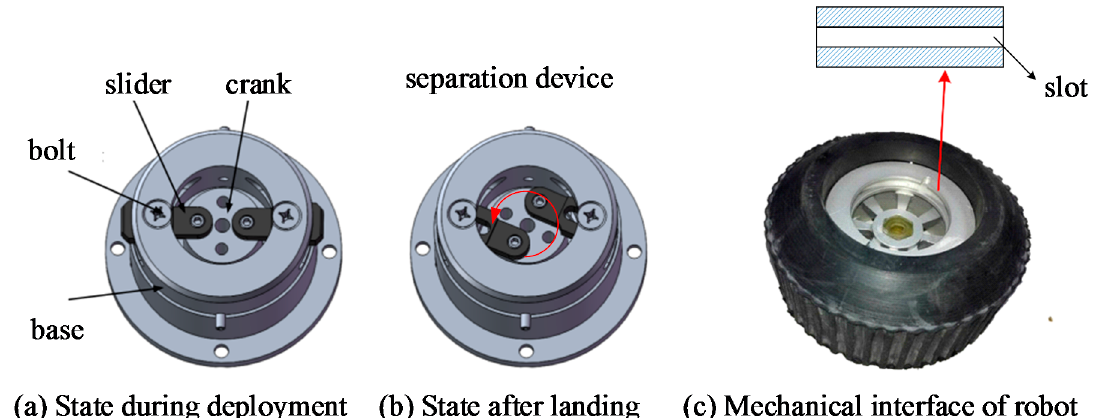
Figure 11. ( a ) States of the separation device during deployment. ( b ) States of the separation device after landing. ( c ) Corresponding mechanical interface of robots.